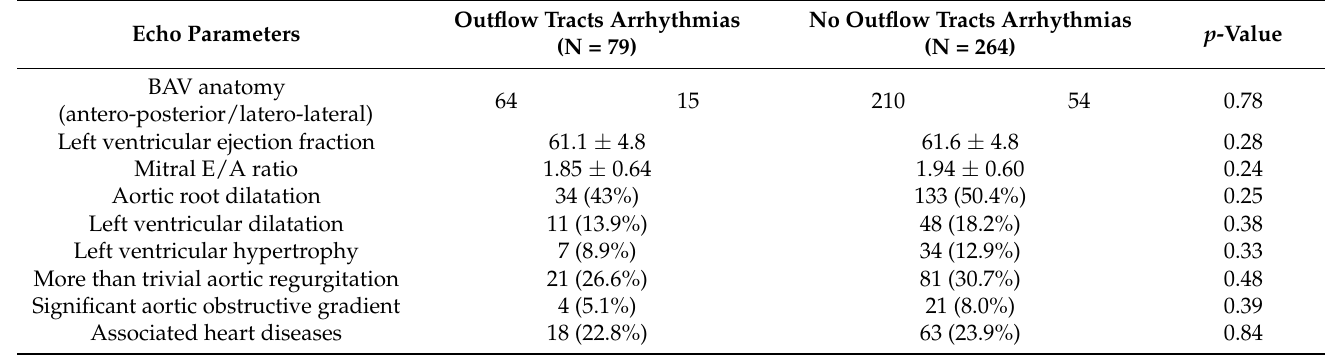
(Table 4): our analysis did not point out a worse echocardiographic status for athletes with PVBs from outflow tracts. Table 4. Comparison of echocardiographic parameters between patients with and without occurrence of outflow tract